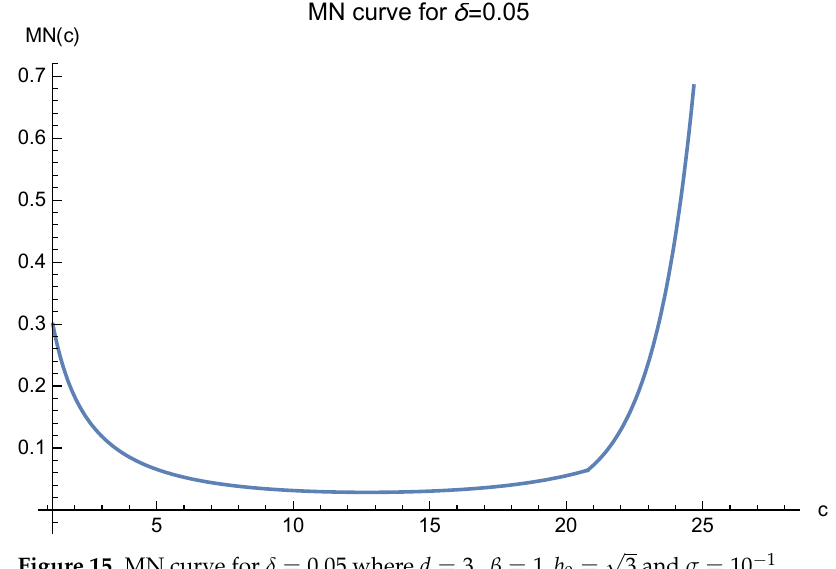
Figure 15. MN curve for δ = 0.05 where d = 3, β = 1, b 0 =